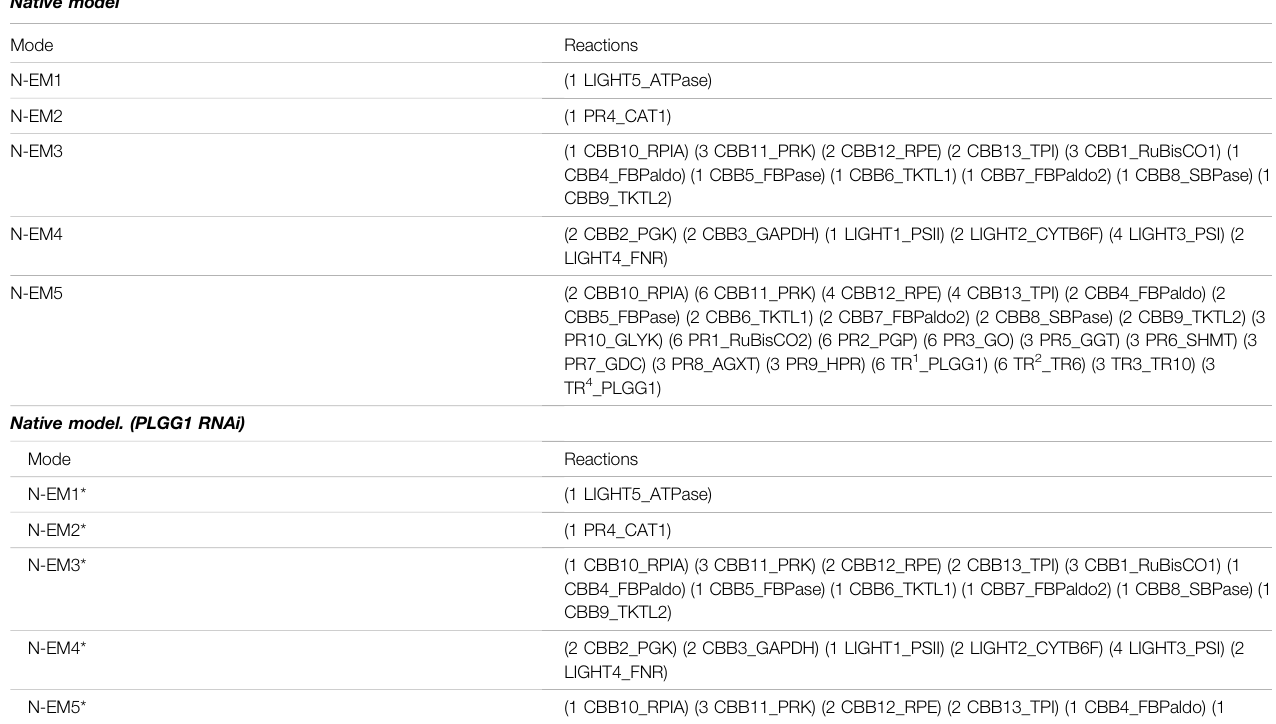
TABLE 1 | Elementary modes in the native model and model with AP3 and CETCH integrated before and after deletion of the PLGG1 transporter. *: PLGG1 RNAi. Native